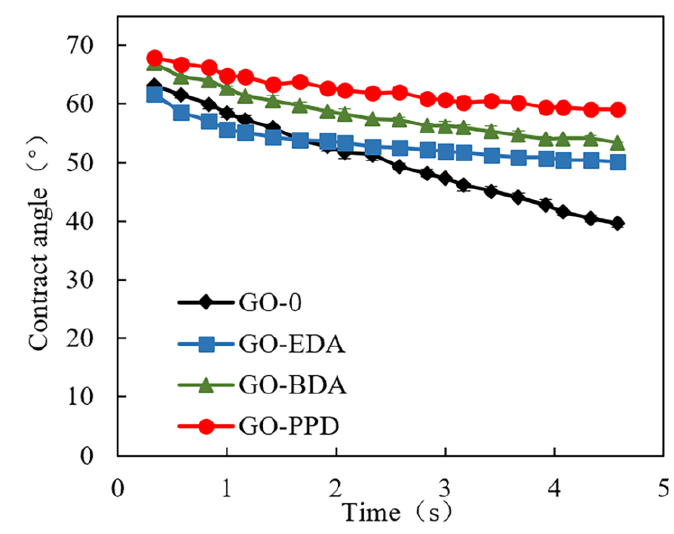
Figure 2. Dynamic contact angle of the various cross-linked GO membranes for 5 s.